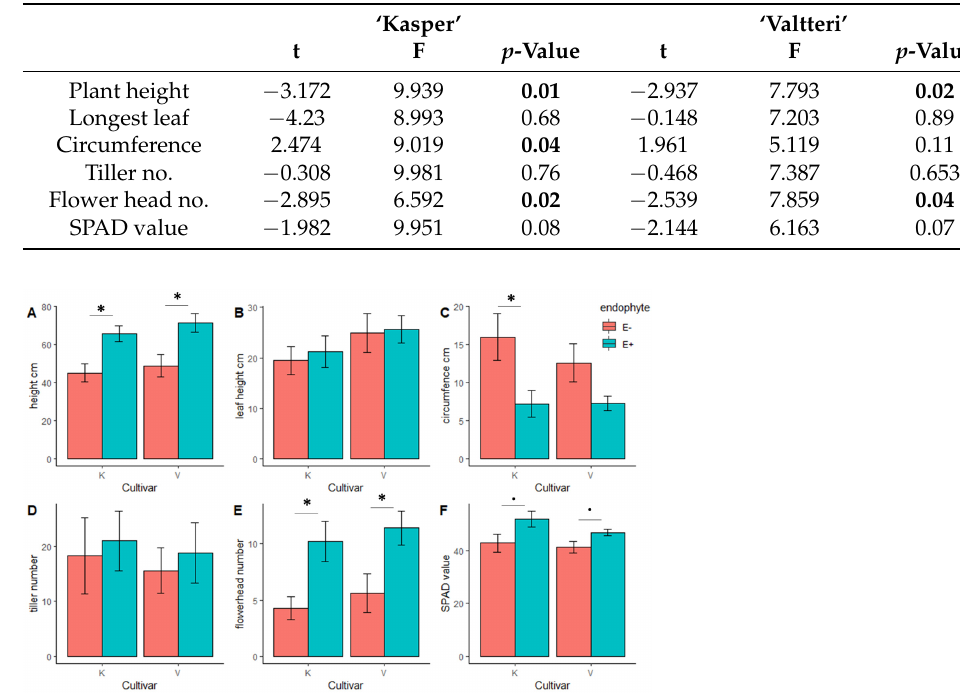
Figure 8. Plant parameters of meadow fescue ( Festuca pratensis ) cultivars ‘Kasper’ (K) and ‘Valtteri’ (V) were compared between Epichloë -symbiotic (E+) and Epichloë -free (E-) plants. Data for ( A ): plant height (cm), ( B ): leaf length (cm), ( C ): circumference (cm), ( D ): tiller number, ( E ): number of flowerheads, and ( F ): SPAD value were analyzed with a Student’s t-test for both cultivars separately. N = 5–6. For significance levels, see Table 4. * = p < 0.05; . = p < 0.1.